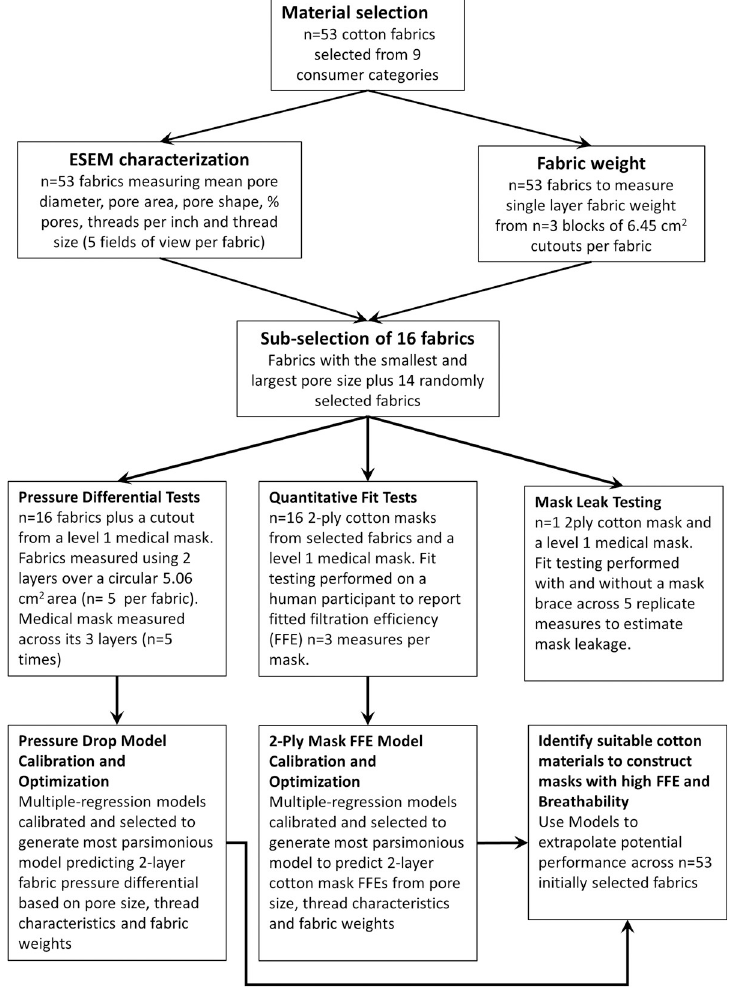
Fig 1. Flow chart of study design used for material and mask characterizations, model calibration and selection of optimum cotton materials for use in constructing 2-ply cotton masks. which horizontal or vertical line of threads counted in a given field of view was at the analyst’s discretion, based on what appeared to be the most representative of the fabric sample. For thread size, two randomly-selected threads from each field of view were measured as the dis- tance ( μ m) across the width of the thread or distinct bundle of fibers. Thread sizes were reported as the mean ± standard deviation of 10 threads measured in each of the horizontal and vertical directions. Pores were defined as gaps or holes present between threads and visu- ally represented as black regions on the ESEM image. A colorization filter was used to aid in pore identification. The analyst used the imaging software to generate a polygon outline of 10 selected pores for each field of view to generate 50 pores characterized for each fabric. Effort was made to select pores with varying size. Pores were selected to avoid those bisected by stray fibers. For each polygon, the imaging software computed the mean pore diameter ( μ m), pore area ( μ m 2 ) and shape factor (value ranging from 0 to 1, with 0 representing a perfectly straight line and 1 representing a circle). The imaging software also reported the total area and % of field of view occupied by black regions on the ESEM image corresponding to the % area of